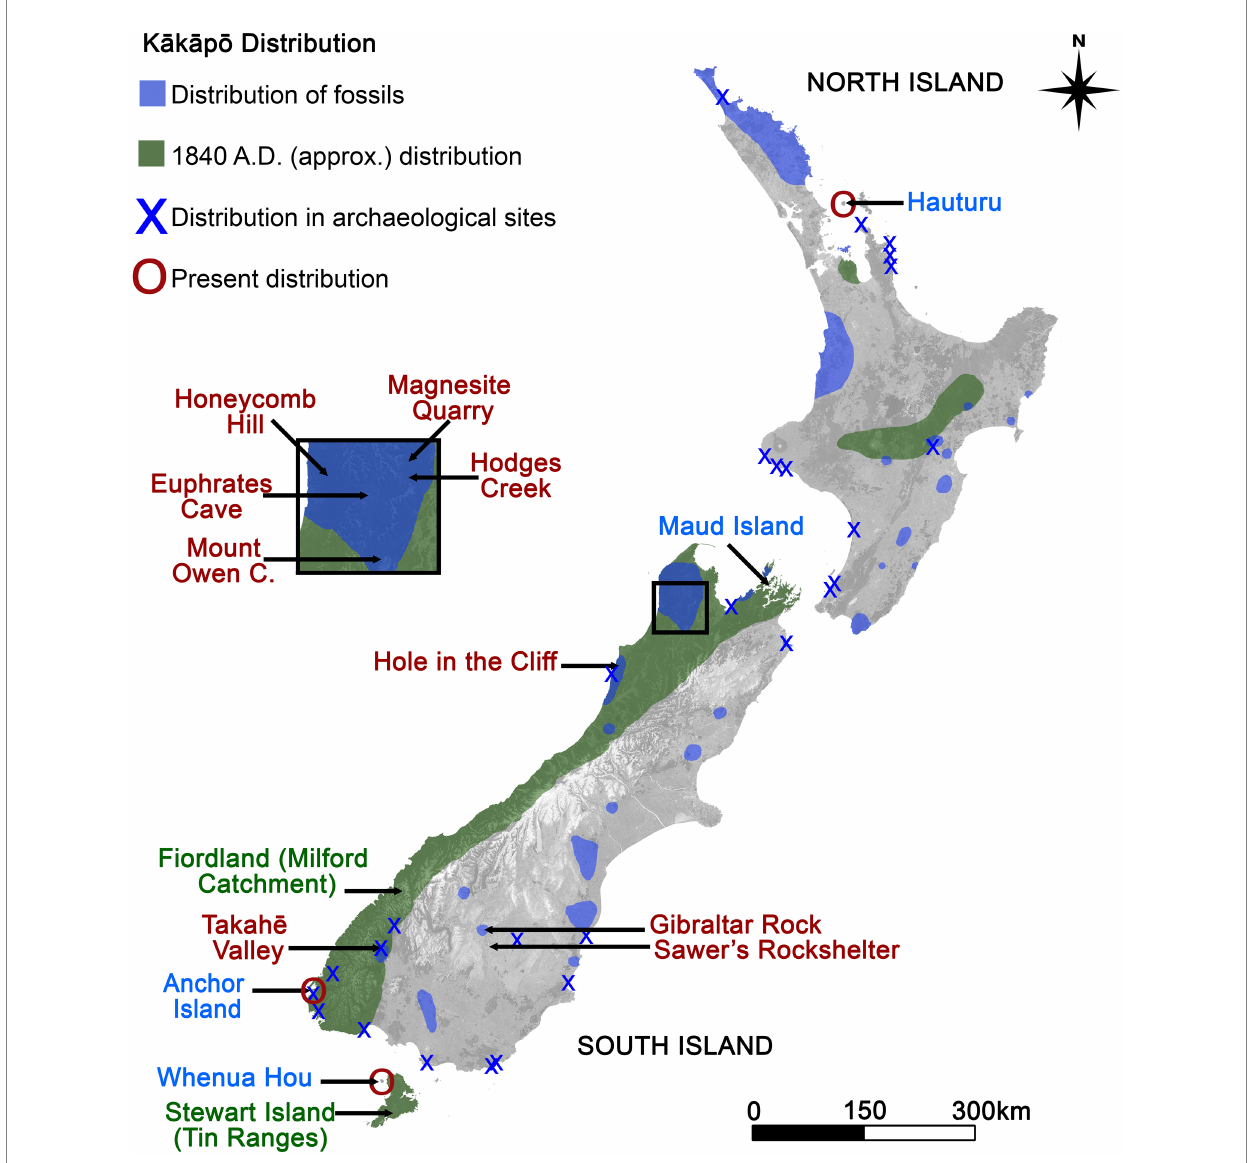
FIGURE 1 Contemporary and former kākāpō distribution, adapted from Boast (2021). Collection sites are plotted, coloured by age group: (Red) ancient, (Green) historic, (Blue)